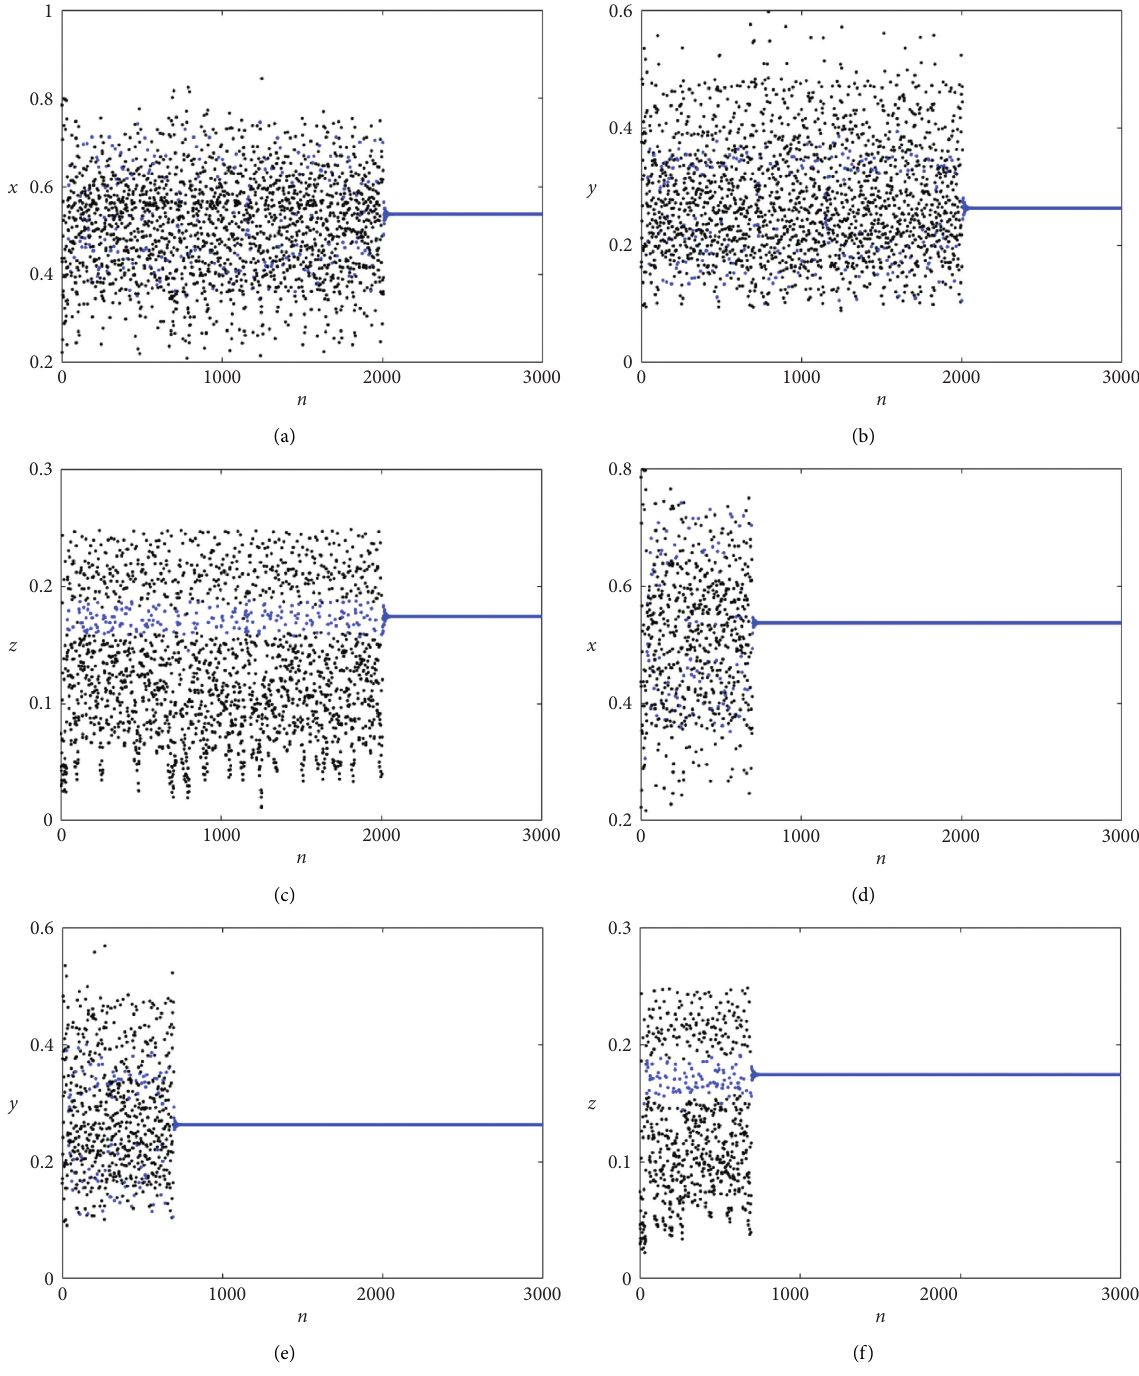
Figure 5: The phase diagrams of equation (5) ((a, b) 2.94 < a < 2.99, (c) a � 3.01, (d, e) 3.01 < a < 3.6, (f) a � 3.87, (g) a � 3.904, and (h–j) 3.904 < a <